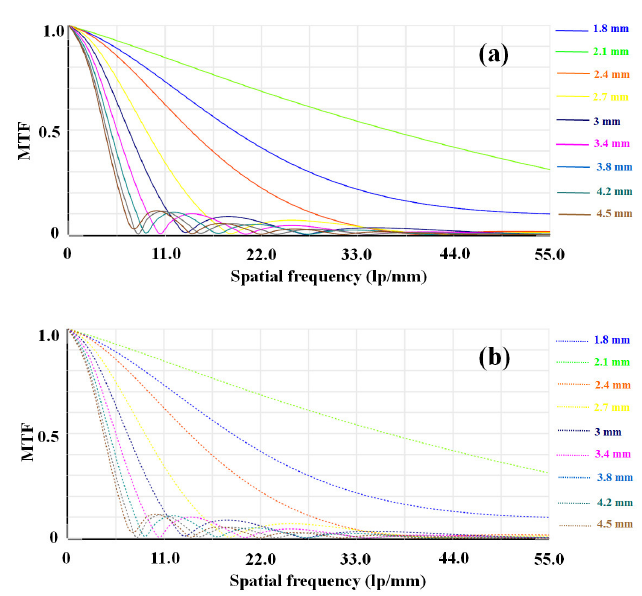
. According 4 × 1.22 × d o × λ